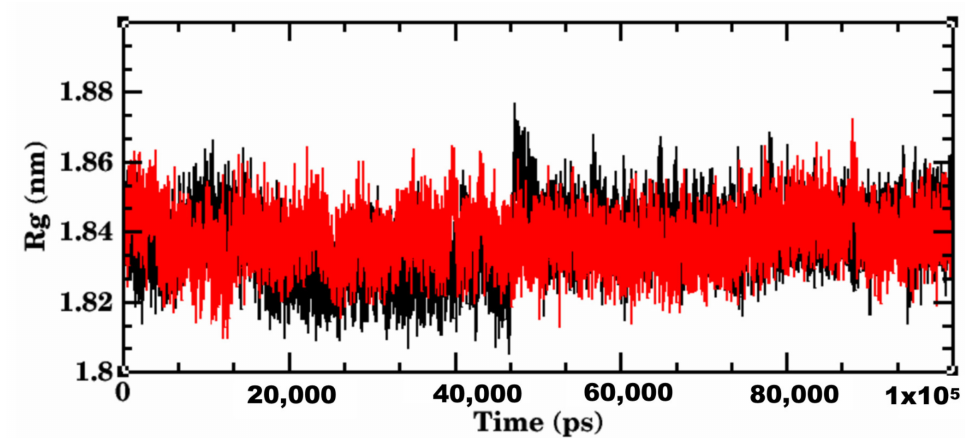
Figure 11. Radius of gyration plot of 100, 000 ps MD simulation illustrating the compactness of the protein-ligand complexes of wild-type-Lupeol (black) and Delta-Betulin (red). No changes were observed in the compactness of both the